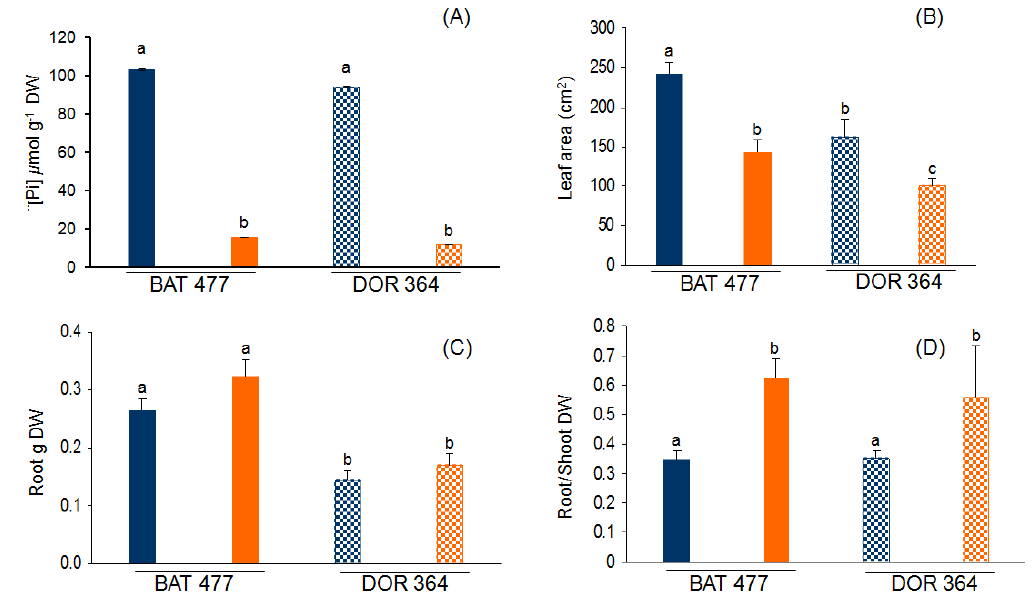
Figure 1. Effect of phosphorus (P) deficiency on common bean BAT 477 and DOR 364 content in leaves; ( B ) leaf area from fully expanded leaves; genotypes. ( A ) soluble P i ( C ) root dry weight; ( D ) root to shoot dry weight ratio. Plants were grown for three weeks under P sufficient (blue bars) or in P deficient (orange bars) conditions. Values are the mean (±SE) from two independent experiments with eight replicates per experiment. Within each panel, bars marked with different letters represent significantly different means according to the statistical analysis ( p ≤